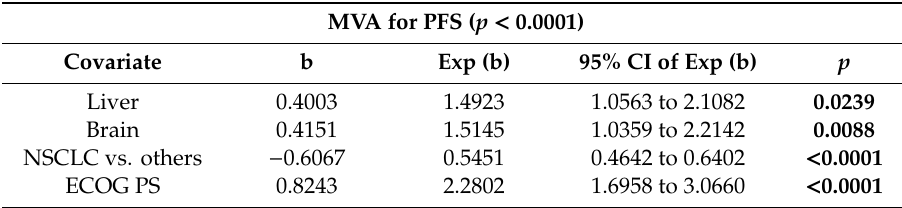
Table 6. Multivariate analysis for